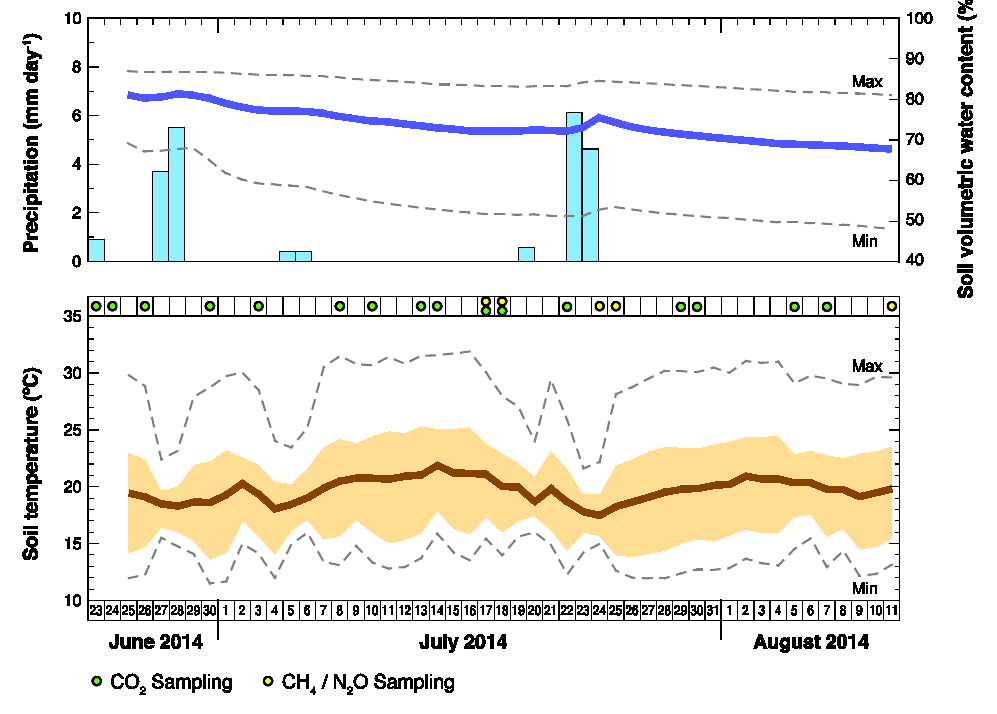
Figure 2. Precipitation and volumetric water content of soil (top panel) and soil temperature (bottom panel) over the period of greenhouse gas (GHG) flux measurements in summer 2014. The green and yellow dots indicate dates when manual soil GHG flux measurements were made to determine carbon dioxide (CO 2 ), methane (CH 4 ) and/or nitrous oxide (N 2 O) fluxes. Soil temperature and soil volumetric water content are ensemble averages for all four sites of the sequence (two replications at each site). For soil temperature, the shaded region shows the daily maximum and minimum of the ensemble soil temperature. The dotted line shows the maximum and minimum of all eight measurements on each day. Precipitation is a composite series between the Environment Canada Climate Station “Delta Burns Bog” and the measurements from the flux tower after 09 July 2014, both located within the BBECA. Table 2. Water table depth, soil water content and soil temperature at the four chamber measurement sites during the measurement period (26 June to 11 August, 2014). Not restored Restored